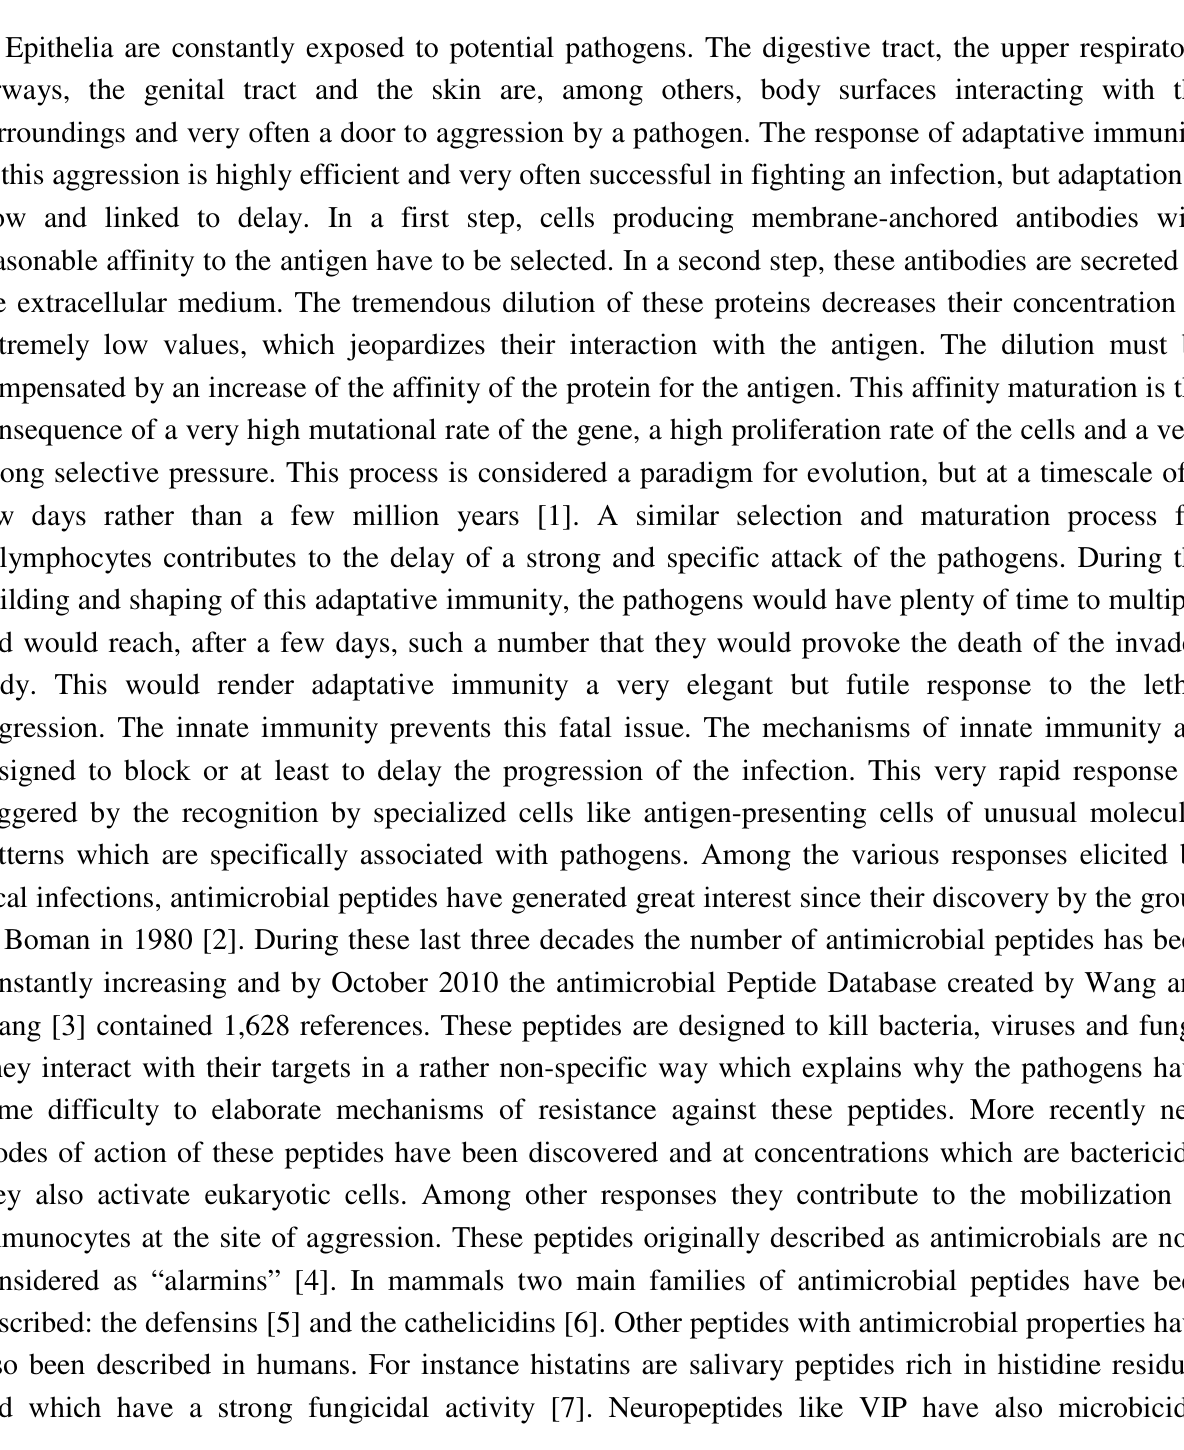
Abbreviations: cDC, conventional dendritic cells; CRAMP, cathelicidin related antimicrobial peptide; EFGR, epidermal growth factor receptor; FPRL-1, formyl peptide receptor-like 1; GPCR, G-protein coupled receptor; IFN, interferon; LPS, lipopolysaccharides; NK cells, natural killer cells; pDC; plasmacytoid dendritic cells; PE, phosphatidylethanolamine;